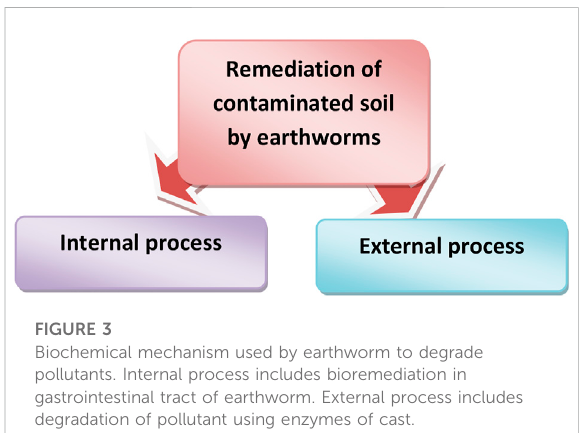
FIGURE 3 Biochemical mechanism used by earthworm to degrade pollutants. Internal process includes bioremediation in gastrointestinal tract of earthworm. External process includes degradation of pollutant using enzymes of